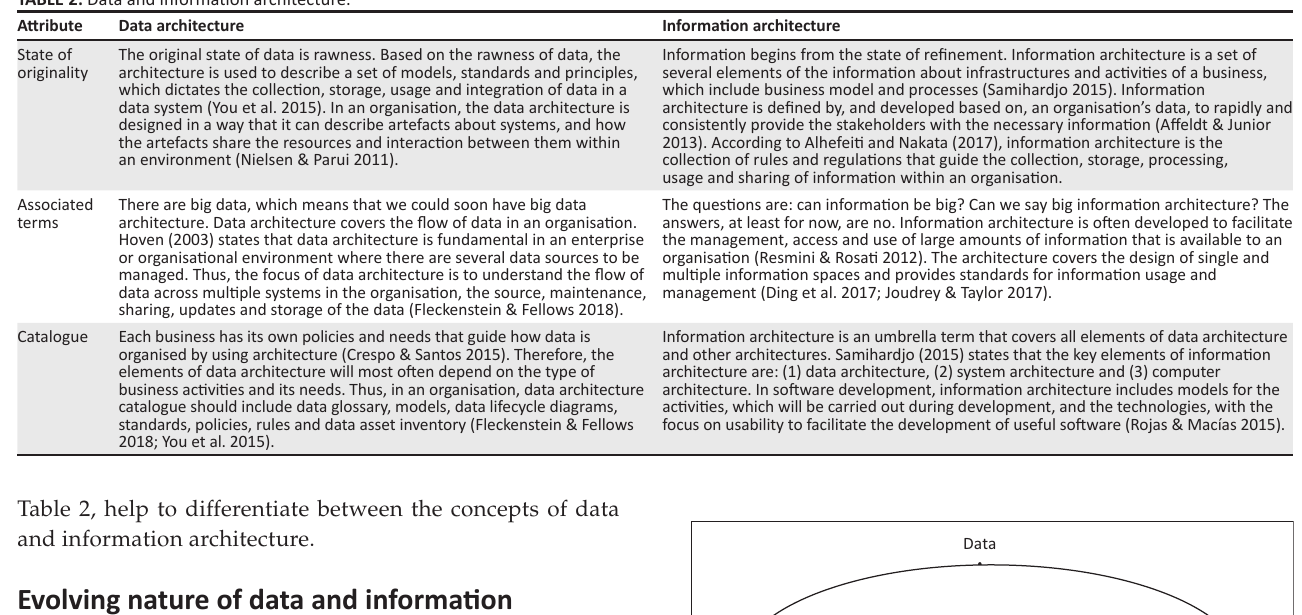
TABLE 2: Data and information architecture. Attribute